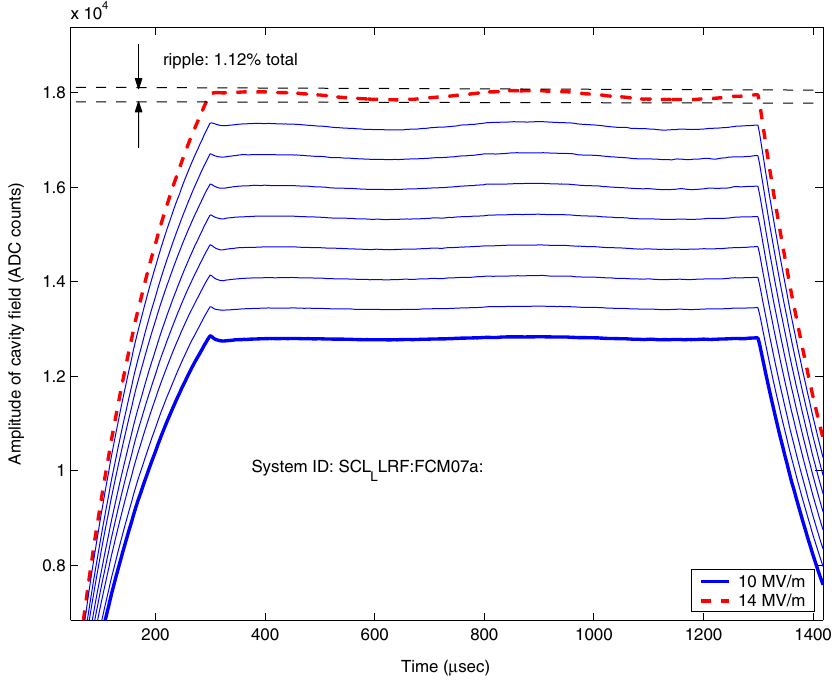
FIG. 10. (Color) The magnitude of 2 kHz mechanical mode grows as the cavity operating field gradient increases beyond the designed 10 MV = m level. The measurement was done on SC cavity SCL-07a, and a moderate loop gain of 41 was used.